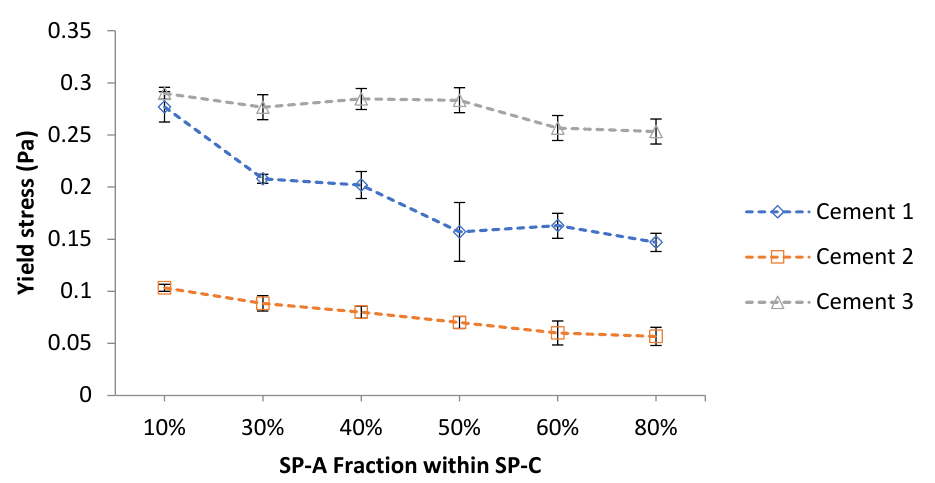
Figure 4. Summary of the yield stress (Pa) values of Cement 1, Cement 2 and Cement 3 with SP-C expressed as a fraction of SP-A at optimum dosage of 0.25%.